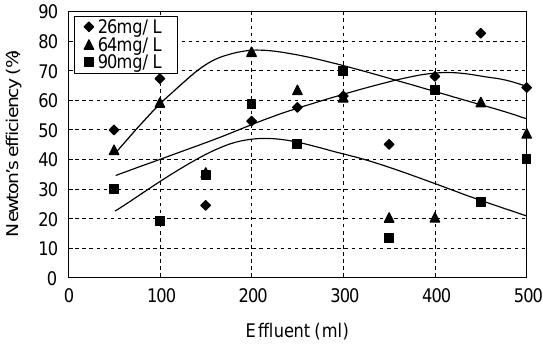
Newton’s efficiency as a function of effluent volume at var- ious silica concentrations. Experimental conditions were pH4.0, KNO 3 concentration 10mM, and superficial velocity